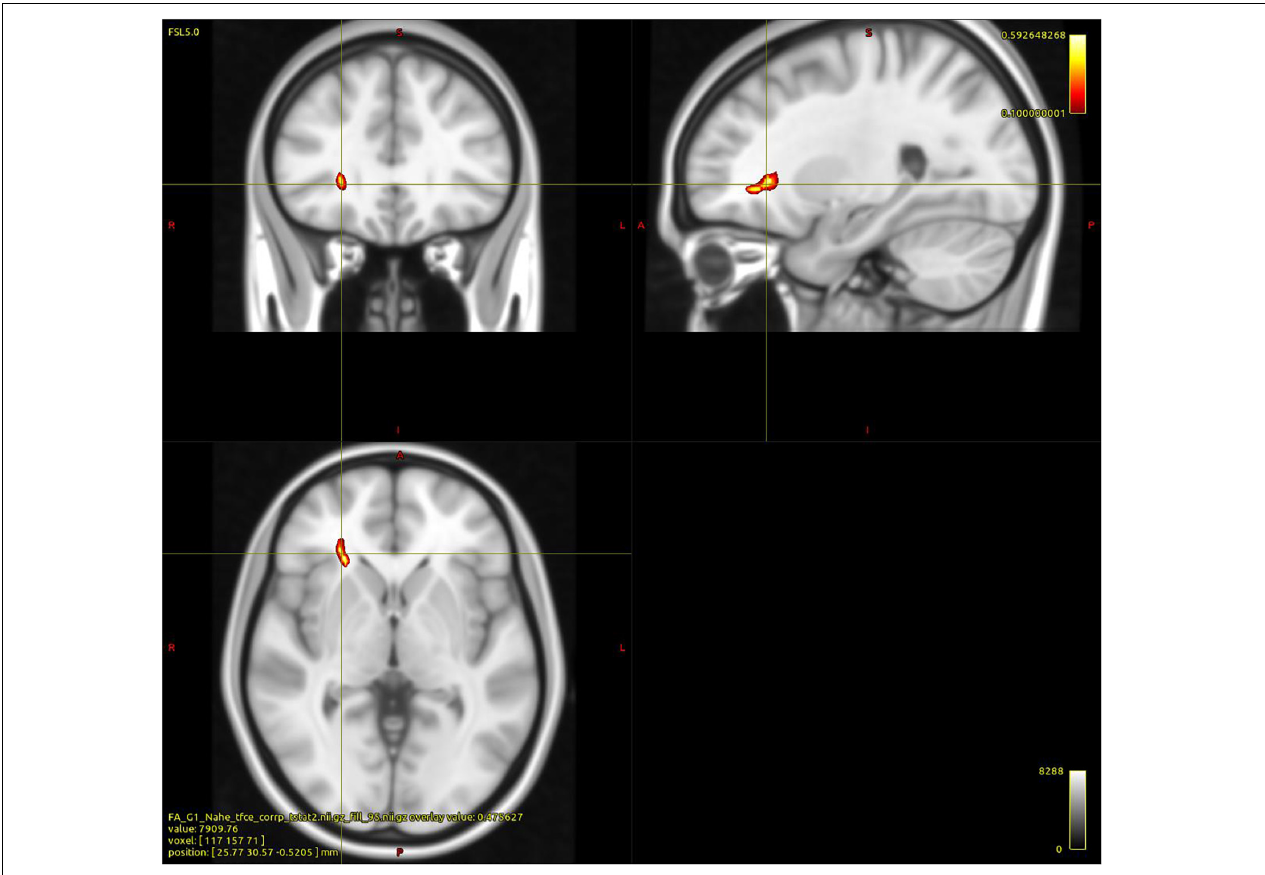
FIGURE 1 | Cluster indicating a negative relationship between WM FA and “Comfort with Closeness” in PUD patients (26 Voxels; p < 0.05; FWE corrected; controlled for age; and study sequence